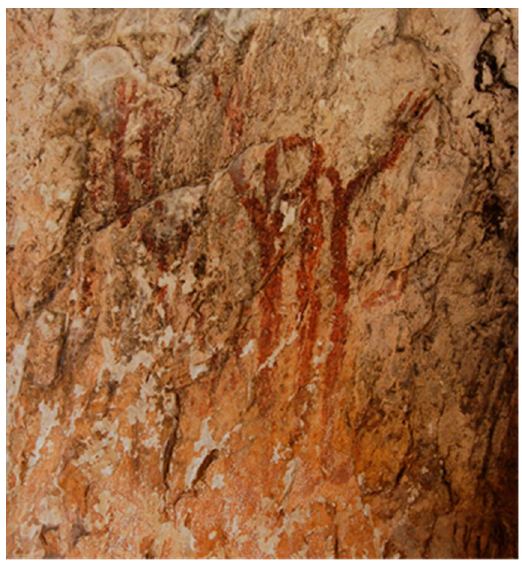
Figure 28. The androgyny of the Barranc de l’infern.